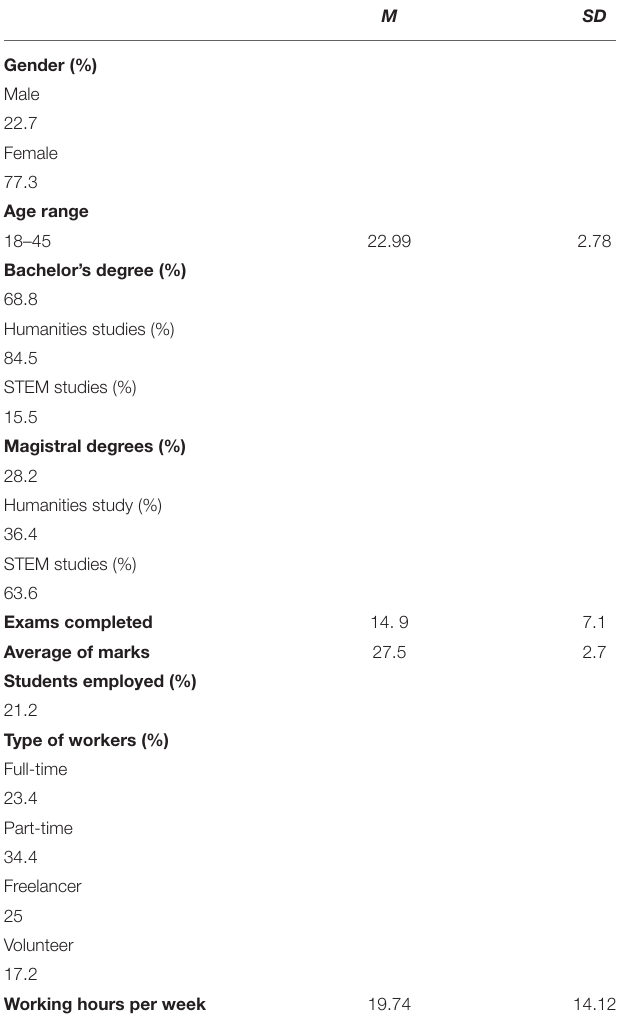
TABLE 1 | Sociodemographic characteristics of students ( N =